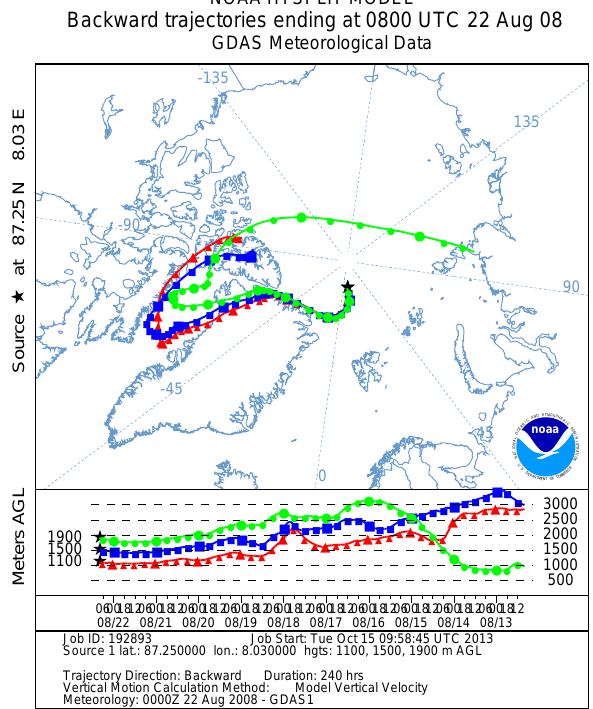
Fig. 11. 10-day backward air mass trajectory ending at 08:00UTC, 22 August 2008 at 87.25 ◦ N 8.03 ◦ E, calculated for 1100m (red), 1500m (blue) and 1900m (green) receptor point altitude. Source: calculated using the HYSPLIT model http://www.arl.noaa.gov/